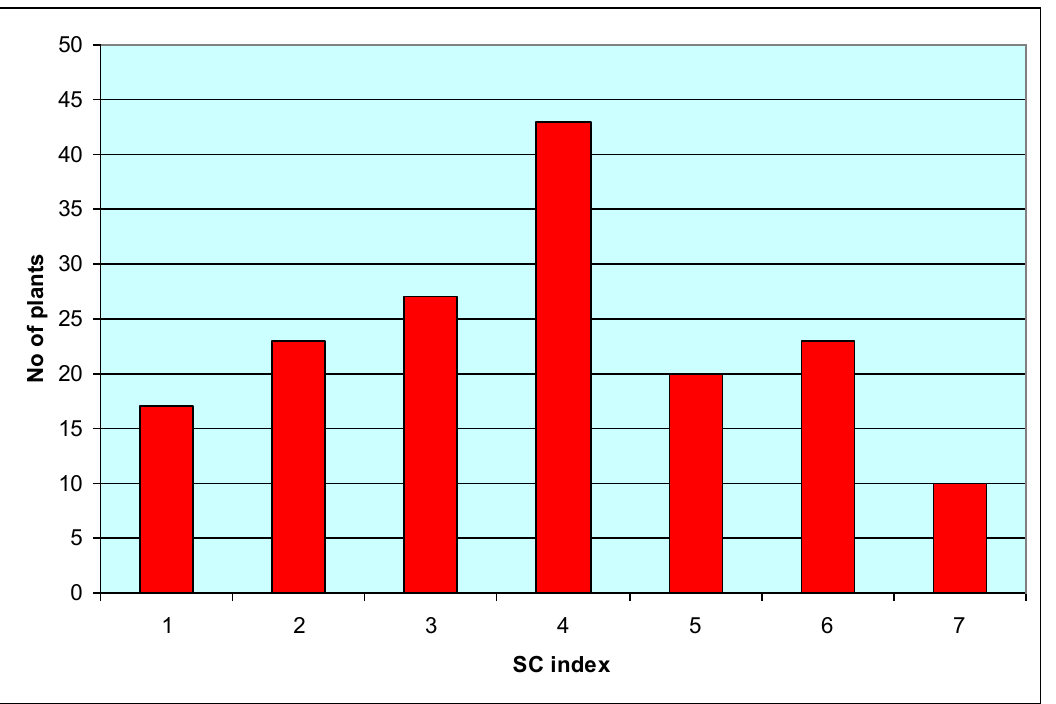
Figure 1. Distribution of the offspring of the almond cross G-4-3 × “Marcona” according to their self-compatibility index (1: Fully self-incompatible; 7: Fully self-compatible; 2–6: intermediate; see Table